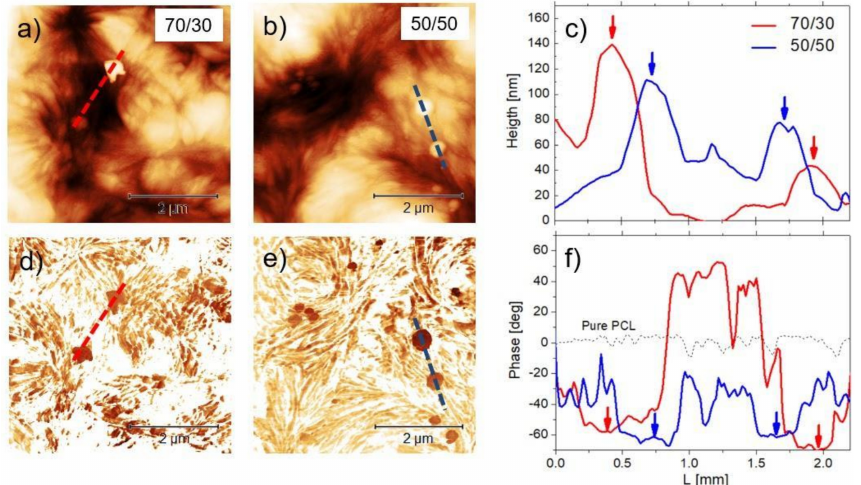
Figure 4. ( a , b ) 5 × 5 µ m 2 AFM height images of the 70/30 and 50/50 formulations with ( c ) cross- sectional traces taken on the two particles. ( d , e ) Phase images corresponding to the topographies above and ( f ) corresponding cross-sectional traces, including the signal corresponding to pure PCL. Arrows are a guide for the eye, indicating height maxima and corresponding phase minima in the two